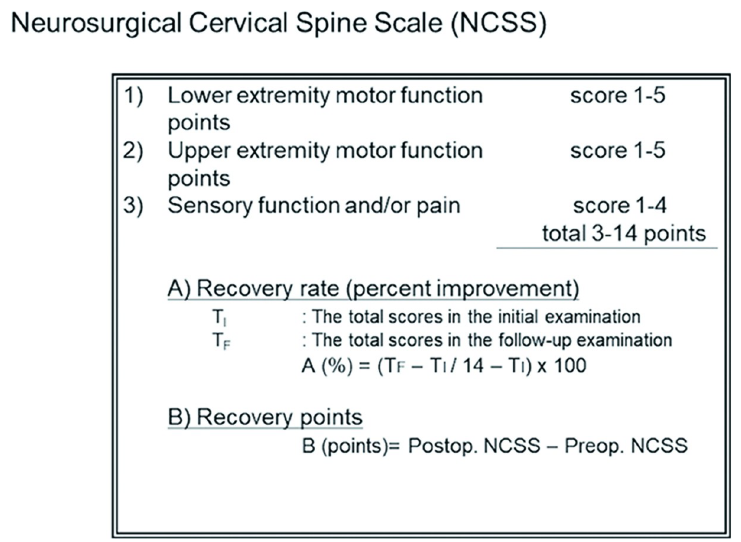
Fig 1. The neurosurgical cervical spine scale (NCSS) grading and scoring system for neurological function in degenerative cervical spine disease. On this scale, healthy individuals receive a score of 14 points. This scale is divided into three categories evaluating motor and sensory function. The higher the NCSS score, the better the functional status of the patient at the time of the assessment. The recovery rate (%) indicates the percent improvement of the patient. In order to clearly understand the patients’ characteristics, “recovery points (points)” were also used in this study. Postop., postoperative; Preop., preoperative.